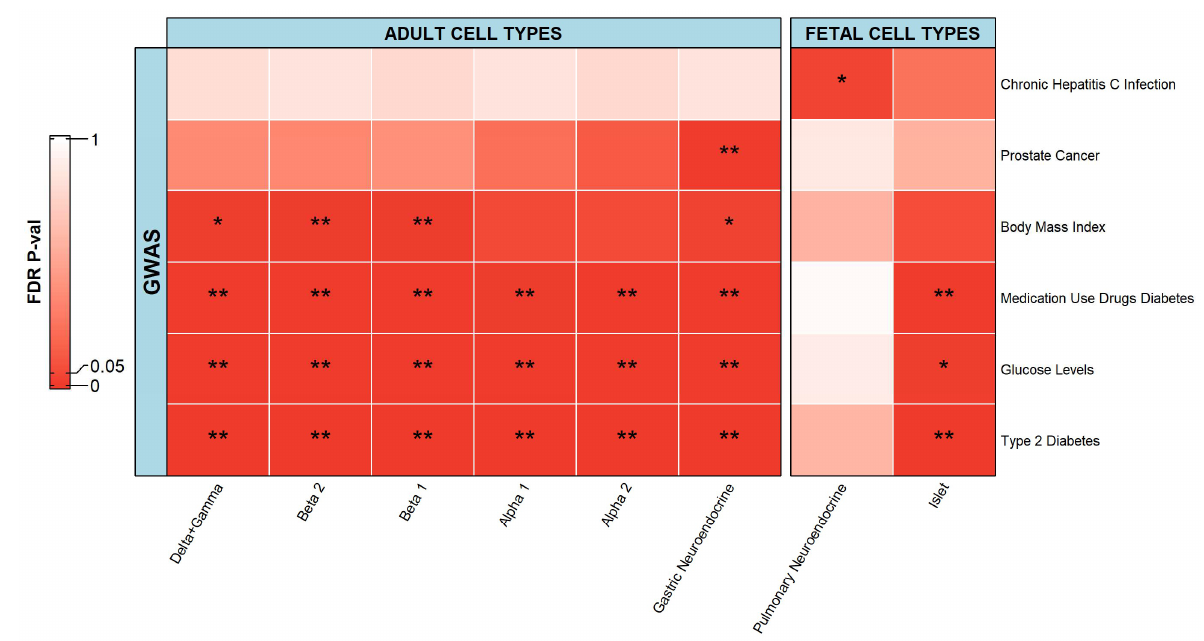
Figure 4. Heatmap depicting associations of islet and neuroendocrine cells from adult and fetal tissue cell types with respective phenotypes. The heatmap follows a gradient from red to white as the values go from 0.00 to 1.00. ** represents a significant association with an FDR adjusted p -value less than or equal to 0.01. * represents a significant association with an FDR adjusted p -value less than or equal to 0.05 but greater than 0.01.